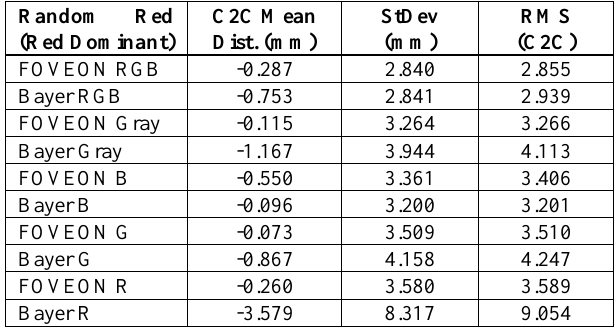
Table 6: Mean Distance, Standard Deviation and RMS error of every point cloud from the reference point cloud for Random Red